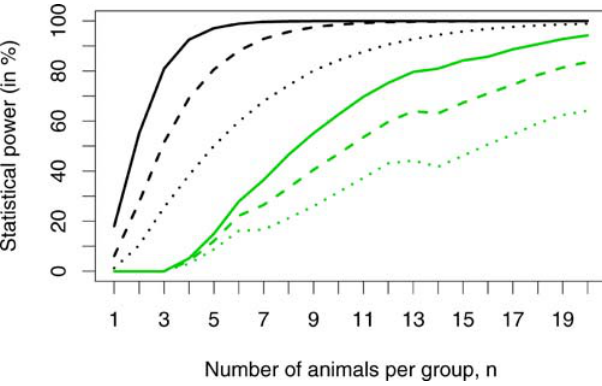
Figure 2. Power Analysis for the Repeated Low-Dose Challenge Design and the Single Low-Dose Challenge Design In our virtual experiments, we set the challenge dose equal to the ID 50 , and assumed that the vaccine efficacy was 67% (dotted lines), 80% (dashed lines), or 90% (solid lines). The graph shows the statistical power of the repeated low-dose challenge design (black lines) and the single low-dose challenge design (green lines) for a given number of animals per group as determined from 100,000 virtual experiments. If the vaccine is 90% effective, the statistical power of the repeated low-dose challenge design is higher than 95% with only five animals per group, as compared to only 15% for the single low-dose challenge design. DOI: